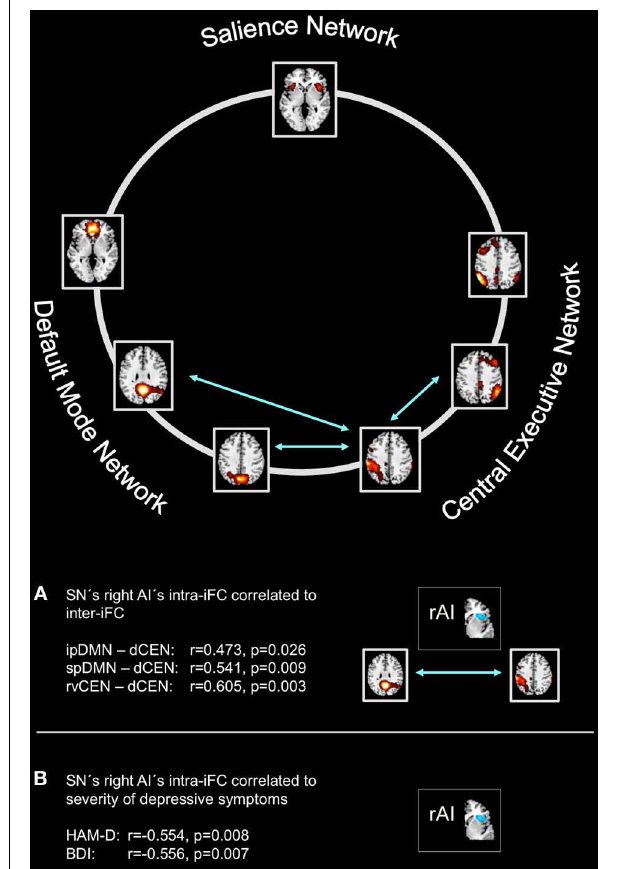
FIGURE 5 | Intra-iFC in the right anterior insula within the salience network is associated with severity of symptoms and inter-iFC between DMN and CEN in patients with major depressive disorder. Intrinsic functional connectivity (inter-iFC) between ICNs of interest was calculated by the use of Pearson’s correlation between networks’ time courses. (A) Intra-iFC in the right anterior insula within the SN (turquoise spatial map) was significantly correlated with severity of negative symptoms in patients with major depressive disorder as measured by both HAM-D (partial correlation, r = − 0 . 554, p = 0 . 008) and BDI (partial correlation, r = − 0 . 556, p = 0 . 007). (B) Intra-iFC in the right anterior insula within the SN was significantly correlated with the inter-iFC between DMN and CEN in patients (turquoise arrows, partial correlations, ipDMN—dCEN: r = 0 . 472, p = 0 . 026; spDMN—dCEN: r = 0 . 541, p = 0 . 009). Furthermore, intra-iFC in the right anterior insula within the SN was significantly correlated with the inter-iFC between distinct subsystems of the CEN (rvCEN—dCEN: r = 0 . 605, p = 0 . 003). All partial correlations were corrected for age, sex, and GM volume of the brain areas covered by the 7 networks of interest. Spatial maps indicate the anterior/inferior-posterior/superior-posterior default mode network (a/ip/spDMN), left-ventral/right-ventral/dorsal central executive network (lv/rv/dCEN), and salience network (SN) (see also Tables 5 – 7 ).